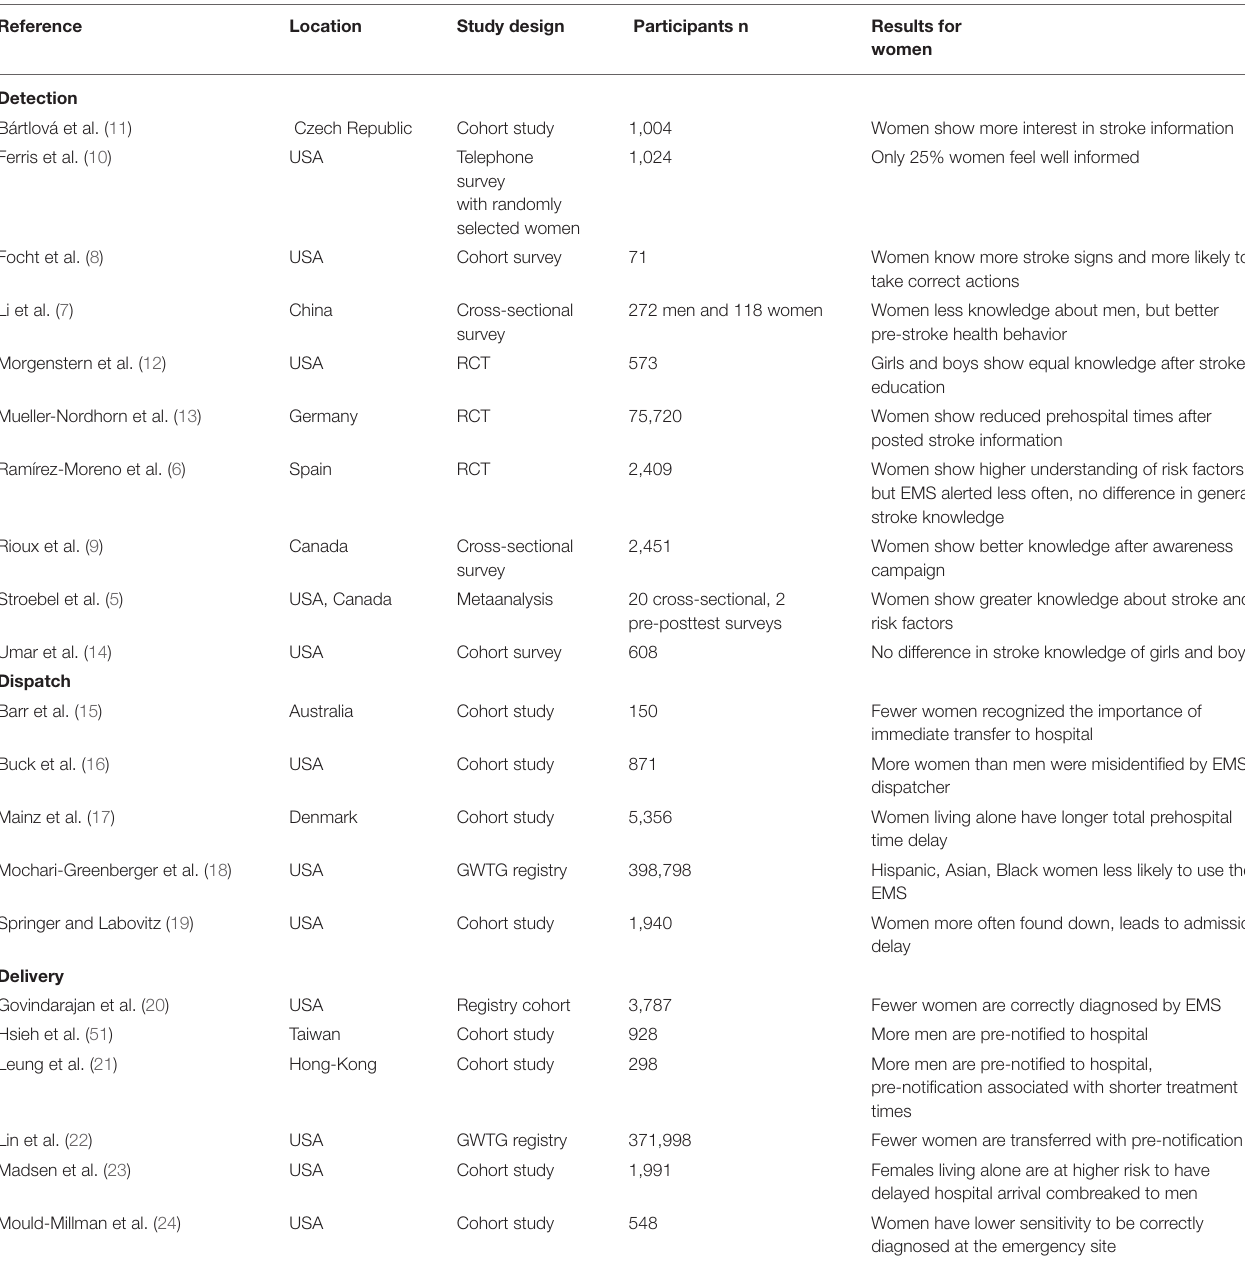
TABLE 1 | Studies addressing gender in prehospital stroke